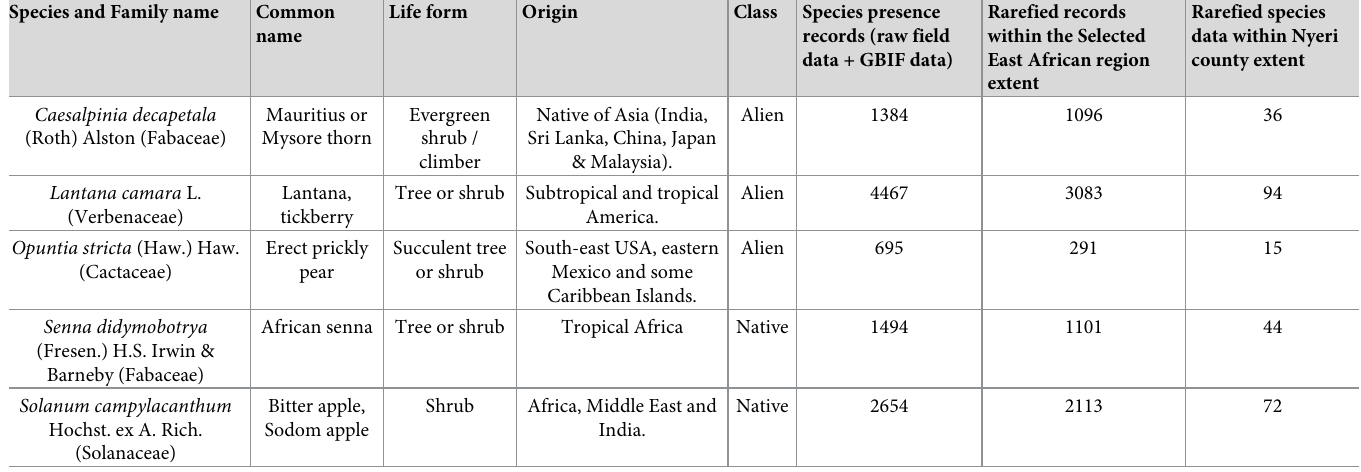
Table 1. Description of study species in terms of species scientific name and family and common name, life form, origin (adopted from Witt & Luke [25]) and the number of records used in